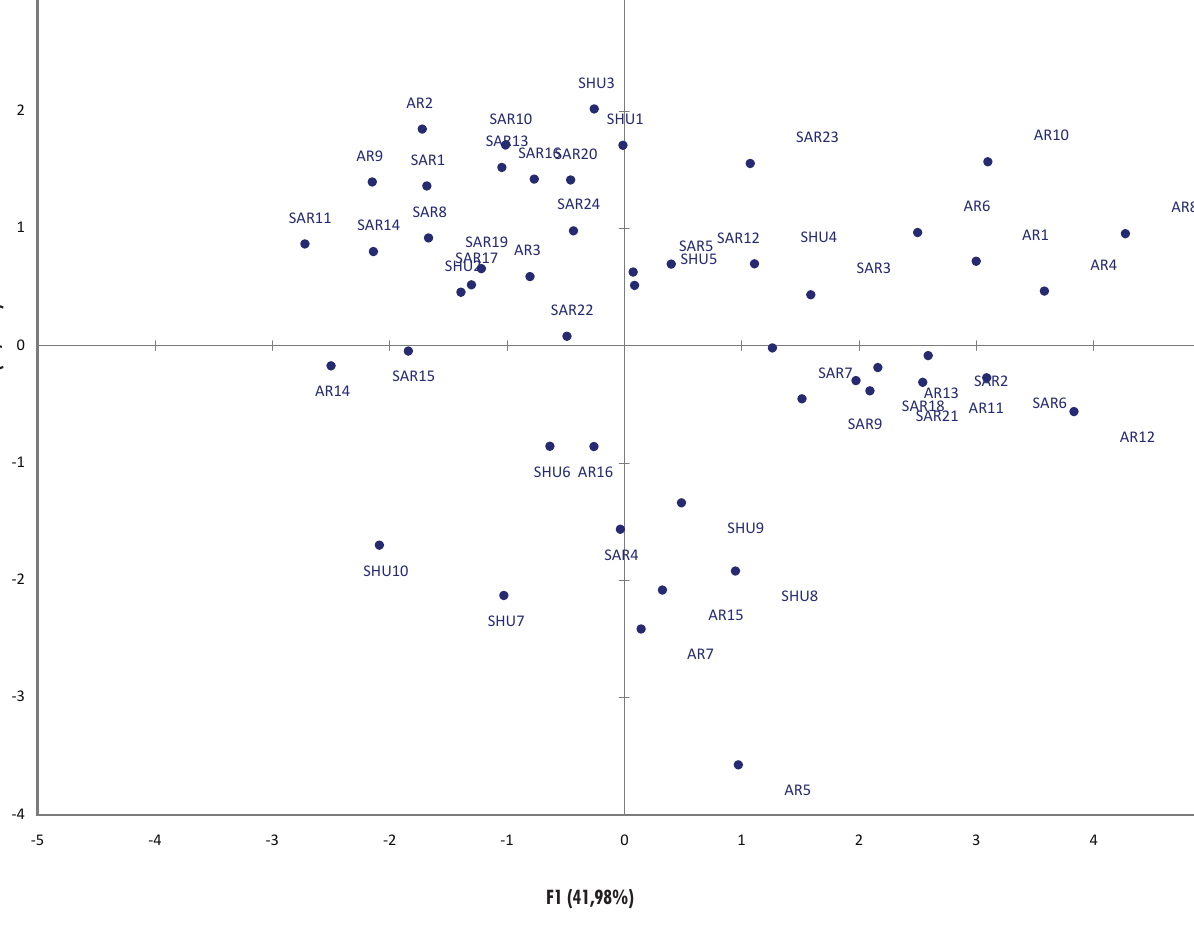
Fig. 1. Principal component analysis of 75 isolates of Mycosphaerella pinodes under axis 1 and 2.